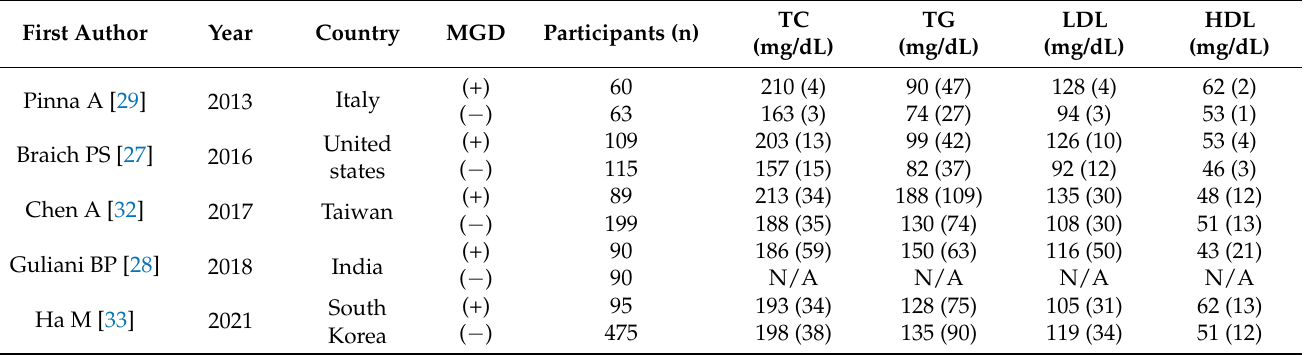
Table 5. Lipid profile among patients with or without meibomian gland